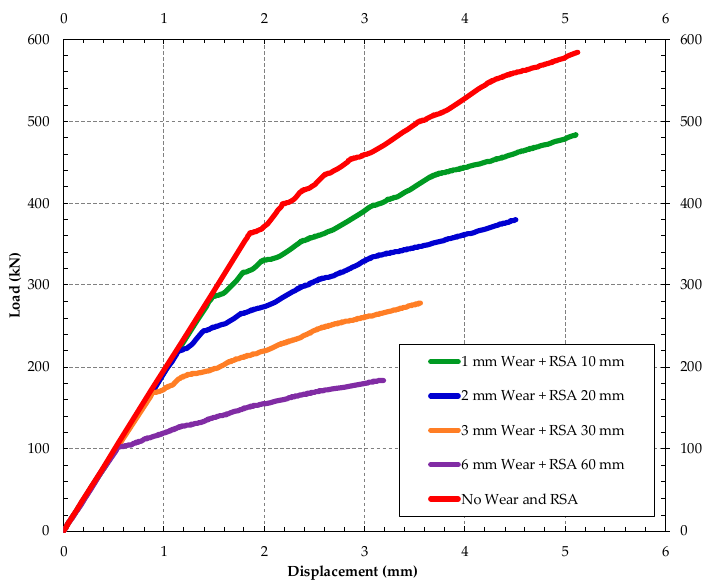
Figure 17. Failure modes for different lengths of pathologies in concrete of the sleeper.